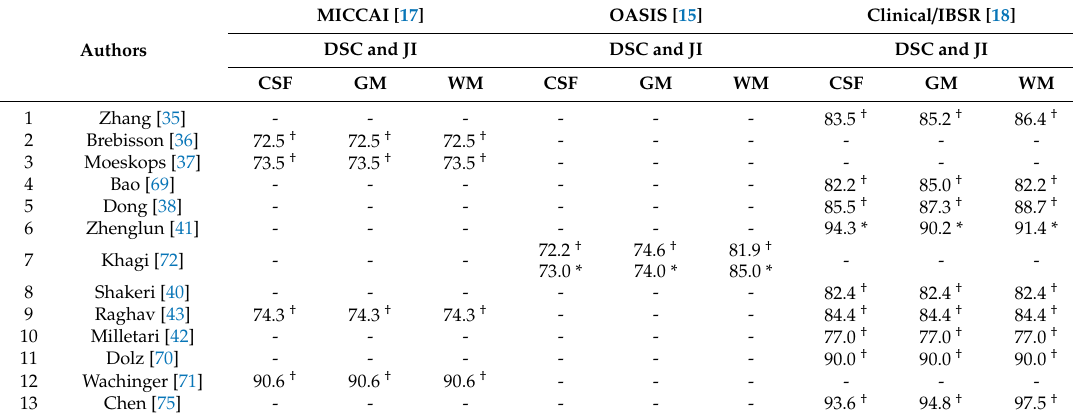
Table 8. Summary of results in the existing methods using deep learning approaches for brain structure segmentation. ( † : DSC, *: JI) (Unit: